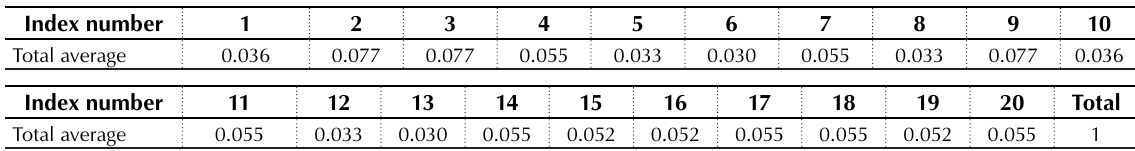
Table 5. Mean values of the questionnaire for determining the importance of each criterion in identifying the labor market type